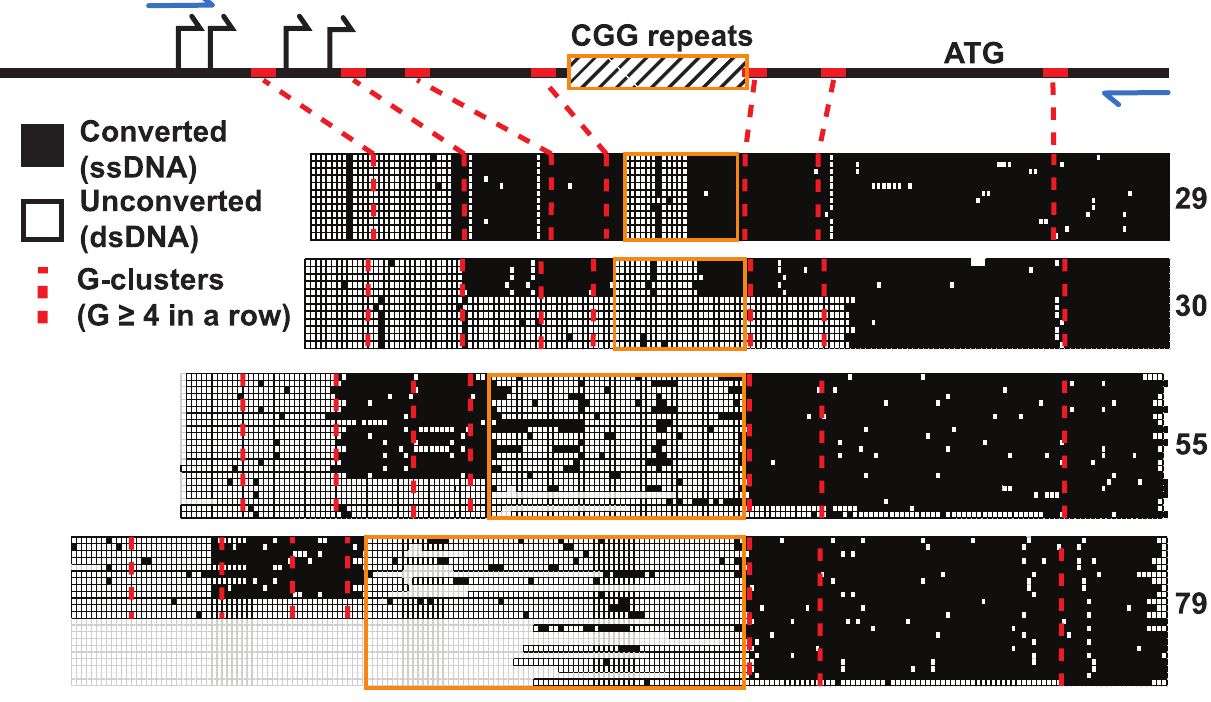
Figure 4. Non-denaturing bisulfite footprinting of the displaced DNA strand of the FMR1 R-loop. Each row represents an individual sequence clone, grouped together for each allele size, from cultured human dermal fibroblasts. Each column is a cytosine position, with filled boxes representing converted, single-stranded DNA and open boxes representing unconverted, double-stranded DNA. Empty boxes represent sequence gaps from bacterial deletion or loss of clean sequencing signal. Schematic diagram at the top represents the FMR1 5 9 UTR with marked TSSs (black arrows), translation start (ATG), CGG repeats (striped box with orange border), PCR primers (blue arrows), and G-clusters (red ticks; red dotted lines).